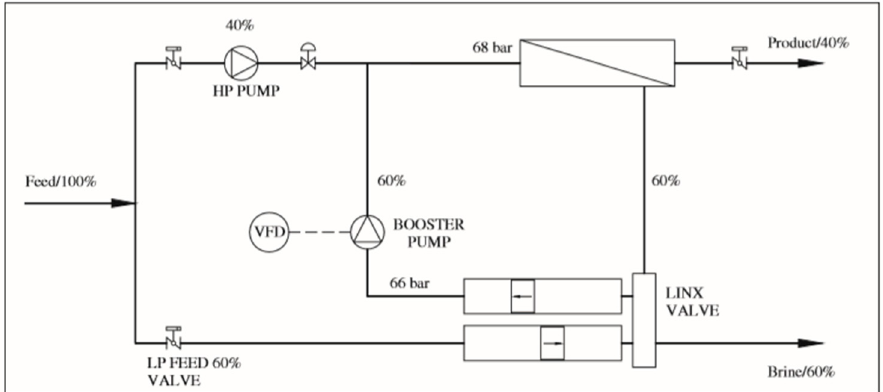
Figure 4. Integration of the work exchanger into a RO desalination system [13].